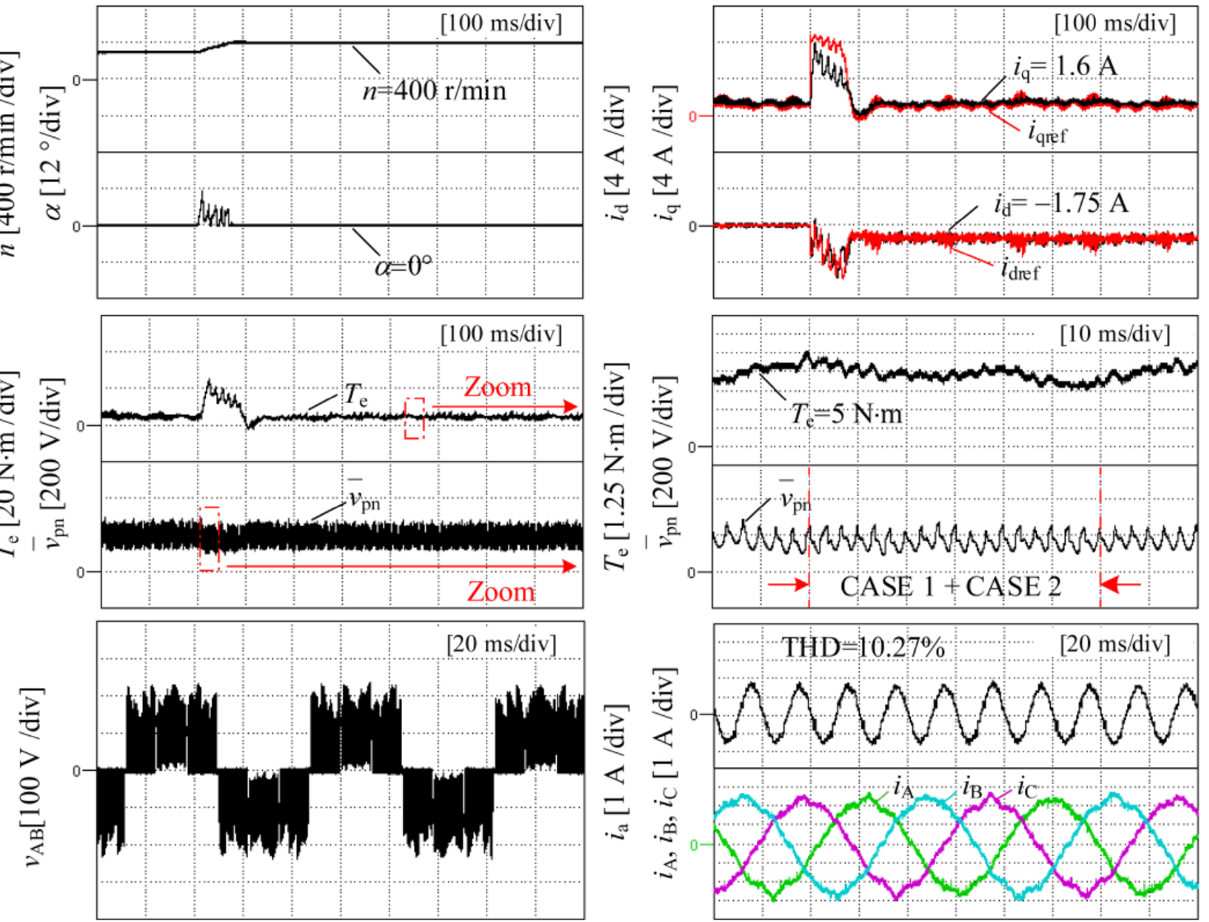
Figure 18. Experimental waveforms of operation Region B.